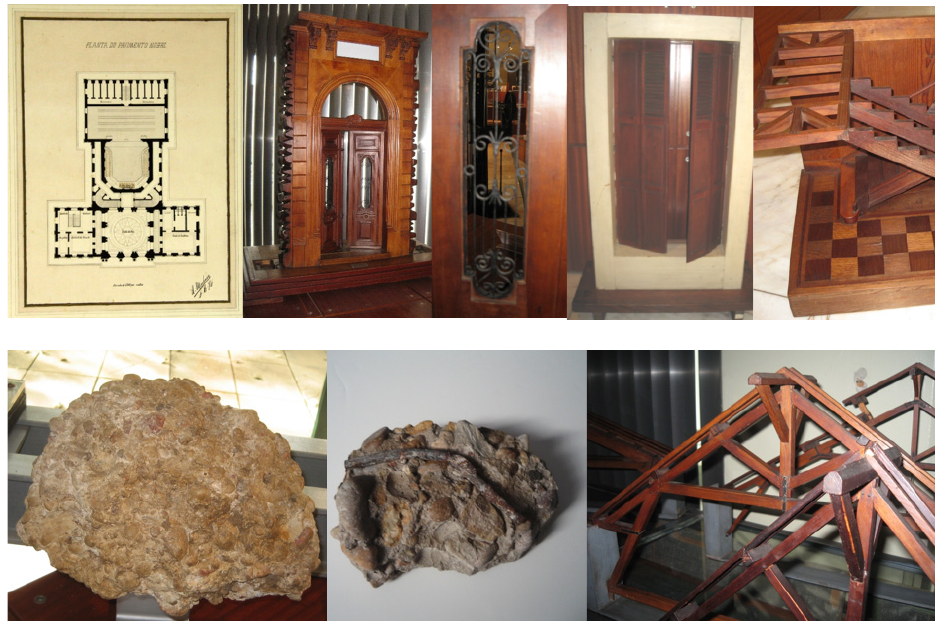
Figure 2. Pieces of the Museum of Civil Engineering, University of Lisbon (Sampaio, 2017a).